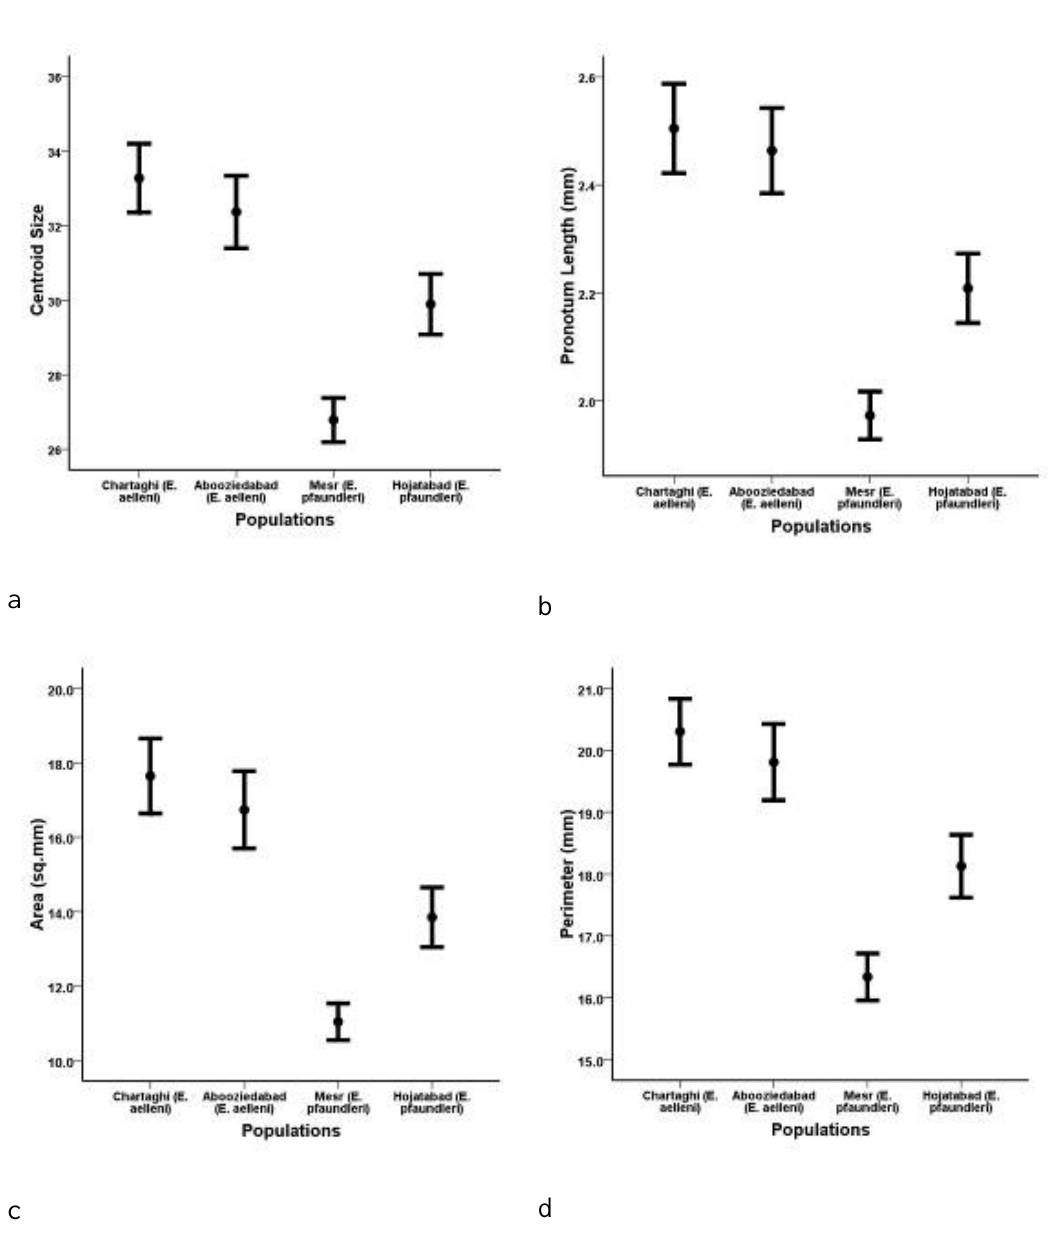
c d F IGURE 7.- Means and 95% confidence intervals for four size variables: a (centroid size), b (pronotum length) c (area), d